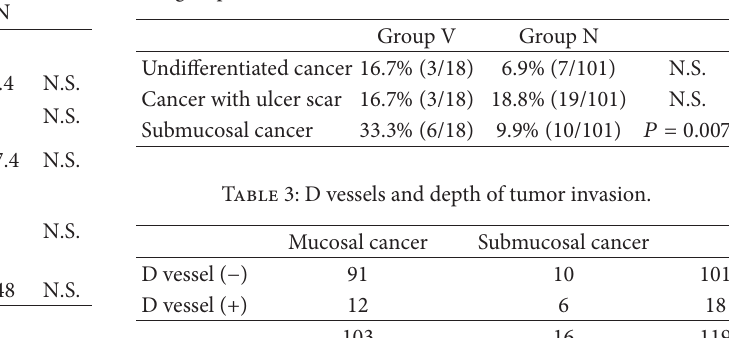
T 2: Comparison of histopathological features of the lesions in two